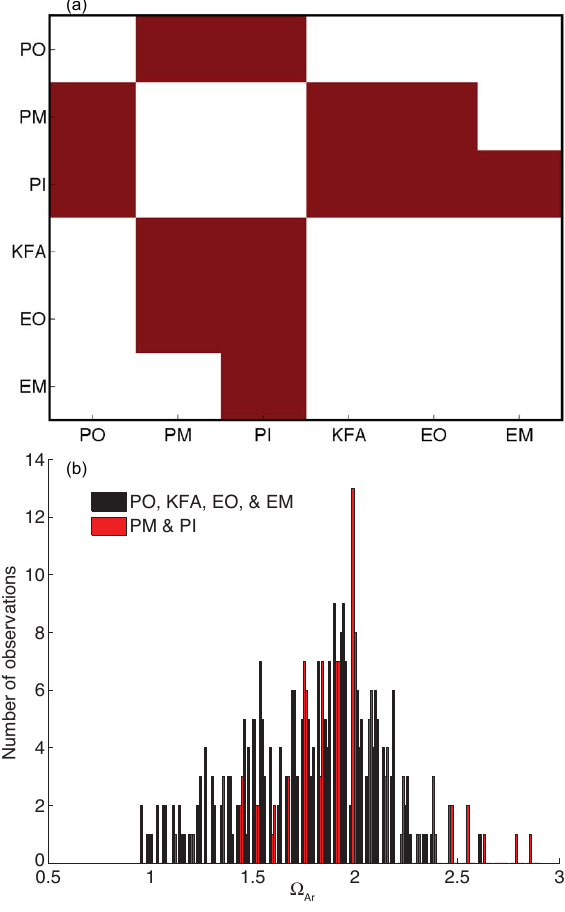
Figure 9. (a) Results of site-to-site bottom (cid:127) Ar Wilcoxon rank sum test. Abbreviations on the sides refer to the six sites. Colored patches indicate significantly different ( p< 0 . 05) bottom (cid:127) Ar be- tween the two sites. (b) Histogram of bottom (cid:127) Ar values group- ing Protected Middle and Inside (red) against the four deeper sites (black). Histogram excludes measurements from July and Au- gust 2013, when samples were not all collected on same